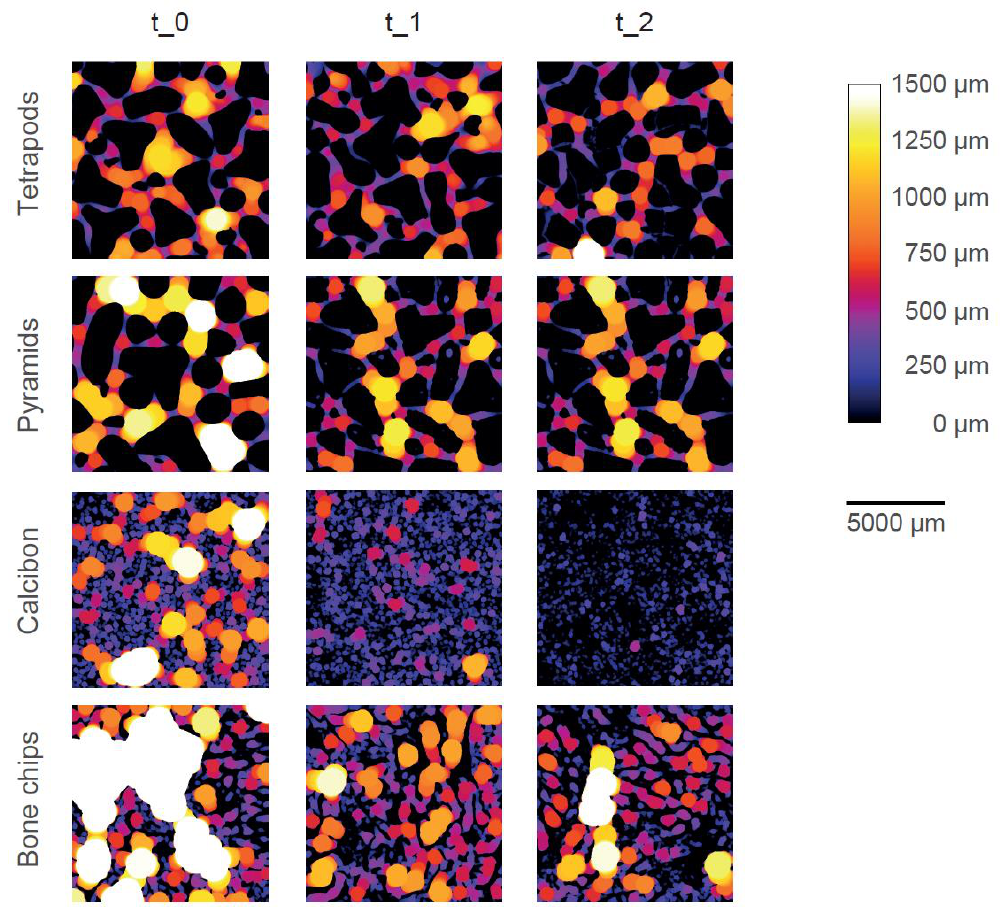
Figure 5. Graphical representation of the pore space of one typical specimen of each bulk material at each timepoint. The size of the pore space is color-coded according to the color bar. Dense material is shown in black. With increasing pore size, the brightness increases, until pore size above 1500 µ m is shown in white.